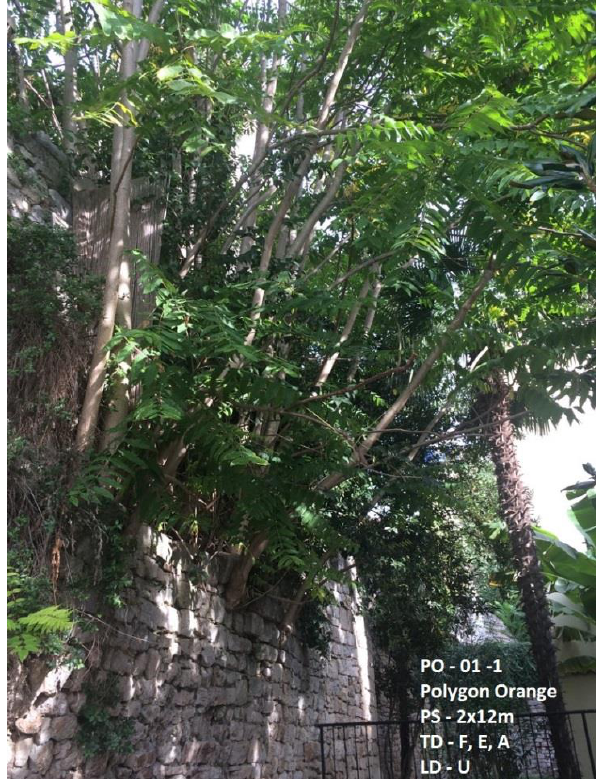
Figure 5. Example of an infestation site with comments assigned to the waypoint. PO-01-1 = Poreč, mapping area 1, infestation site 1; Polygon orange = dense infestation areas (2–5 plants/m 2 ); PS = polygon size; TD = type of damage, F (functional), E (environmental), A (aesthetic); LD = location of damage, U (urban).